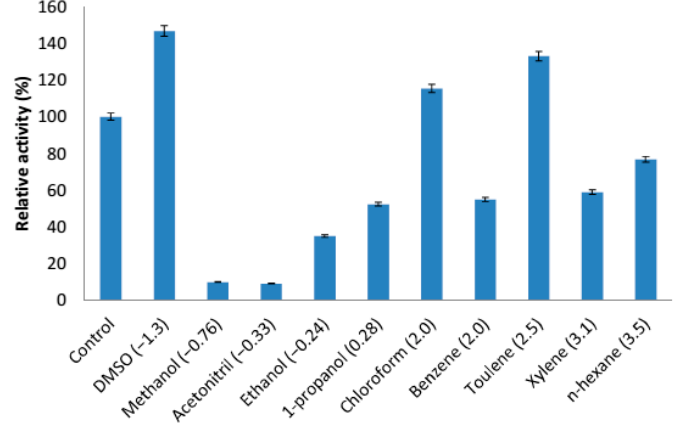
Figure 11. Effect of organic solvents on purified truncated AMS3 lipase. The lipase activity was expressed relative to the control (without solvent). Log p (water/octanol coefficient) value of each solvent is presented in parenthesis. 25% v / v organic solvents were used.